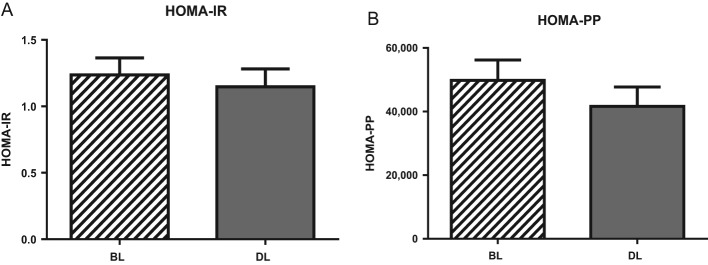
HOMA-IR (A) and HOMA-PP (B) (mean ± s.e.m.) during BL and DL ▬ sessions (n = 17).